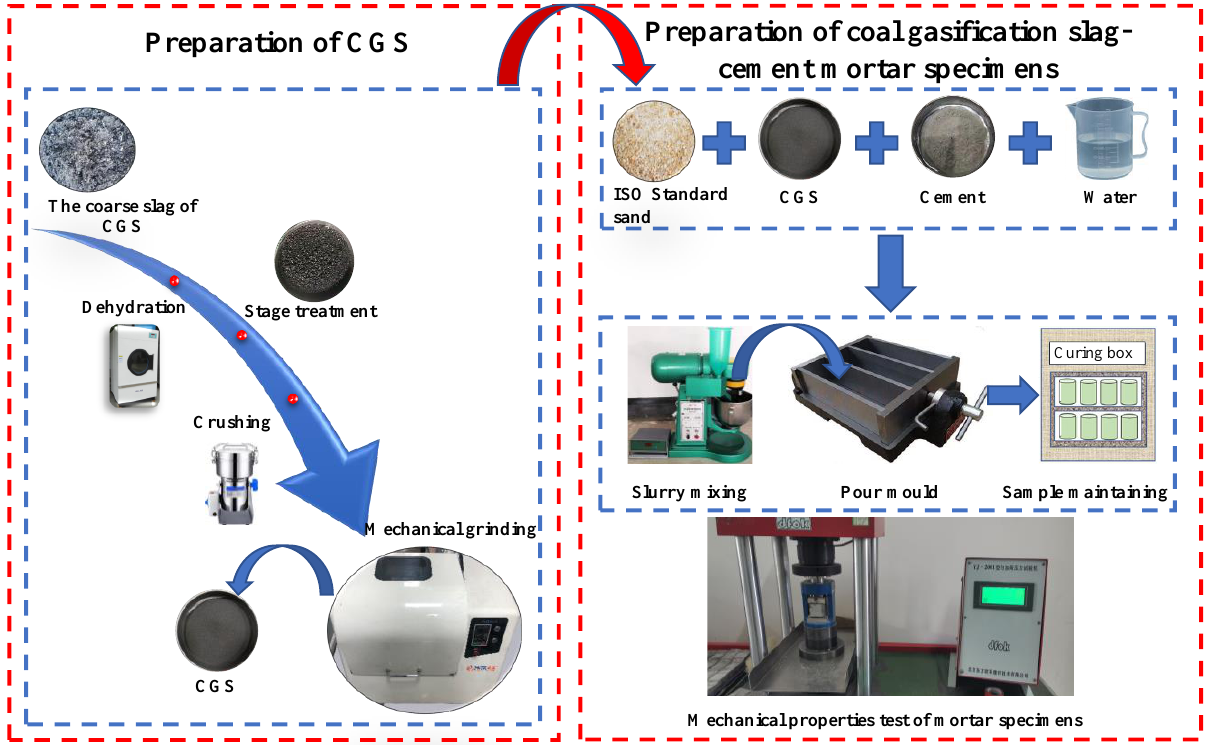
Figure 2. Preparation process of CGS powder and mortar sample.